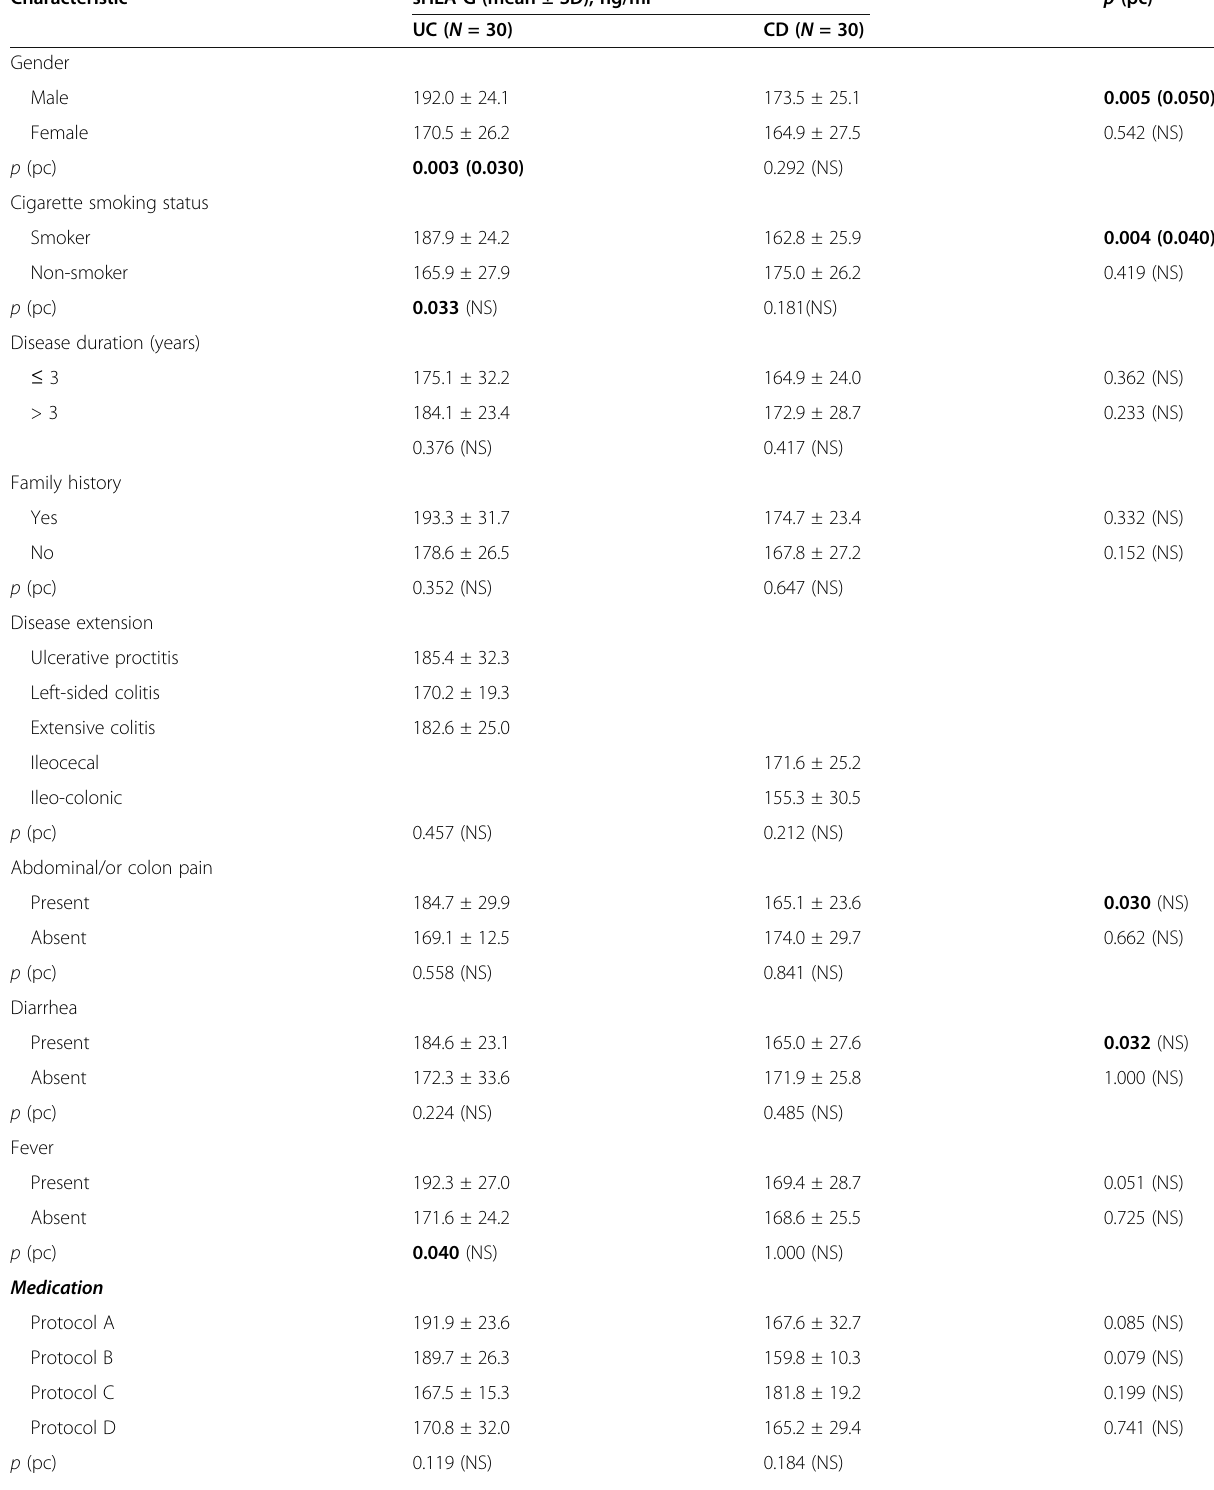
Table 3 Serum level of soluble HLA-G antigens in ulcerative colitis and Crohn ’ s disease distributed according to some characteristics of